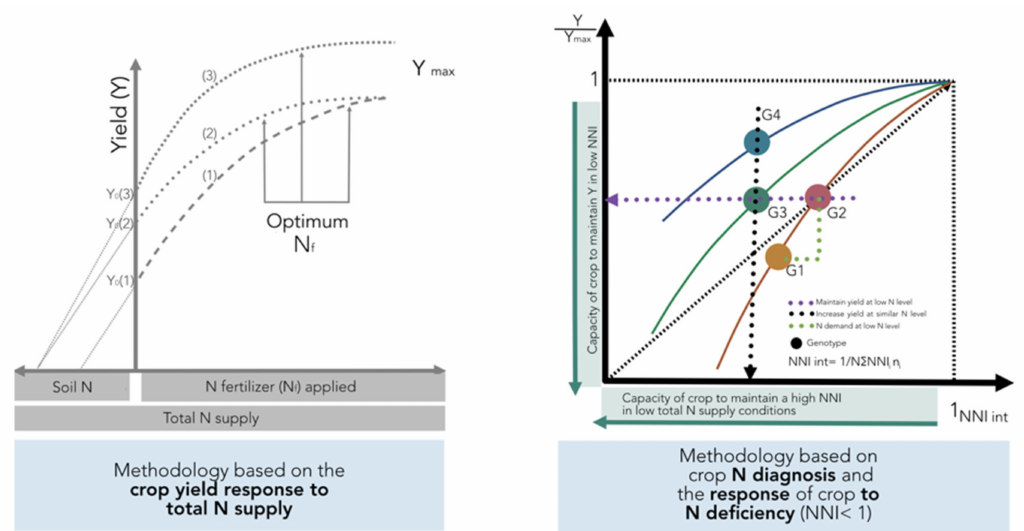
Figure 10. Response of crop yield (Y) to N fertilizer application rates (N f ) according to variations in soil N supply (Ns) (presented in Figure 1, left panel, methodology using crop yield response to total N supply), relative yield (to the maximum yield in each environment), and integrated N nutrition index (NNI, calculated as the NNI obtained at di ff erent growth stages of the crop; a methodology using crop N diagnosis and the response of the crop to N deficiency). Note: for the new approach, comparisons using yield should be done at equal values of harvest index (HI); if HI di ff ers among genotypes, then the best parameter to evaluate is not yield but whole-plant